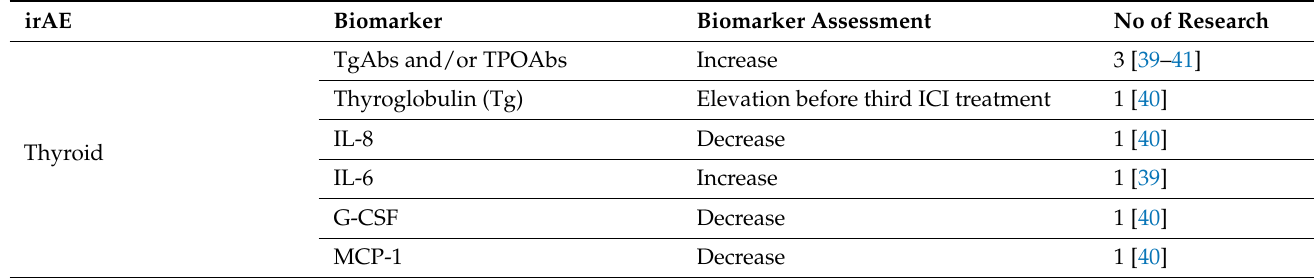
Table 2. During treatment biomarkers for